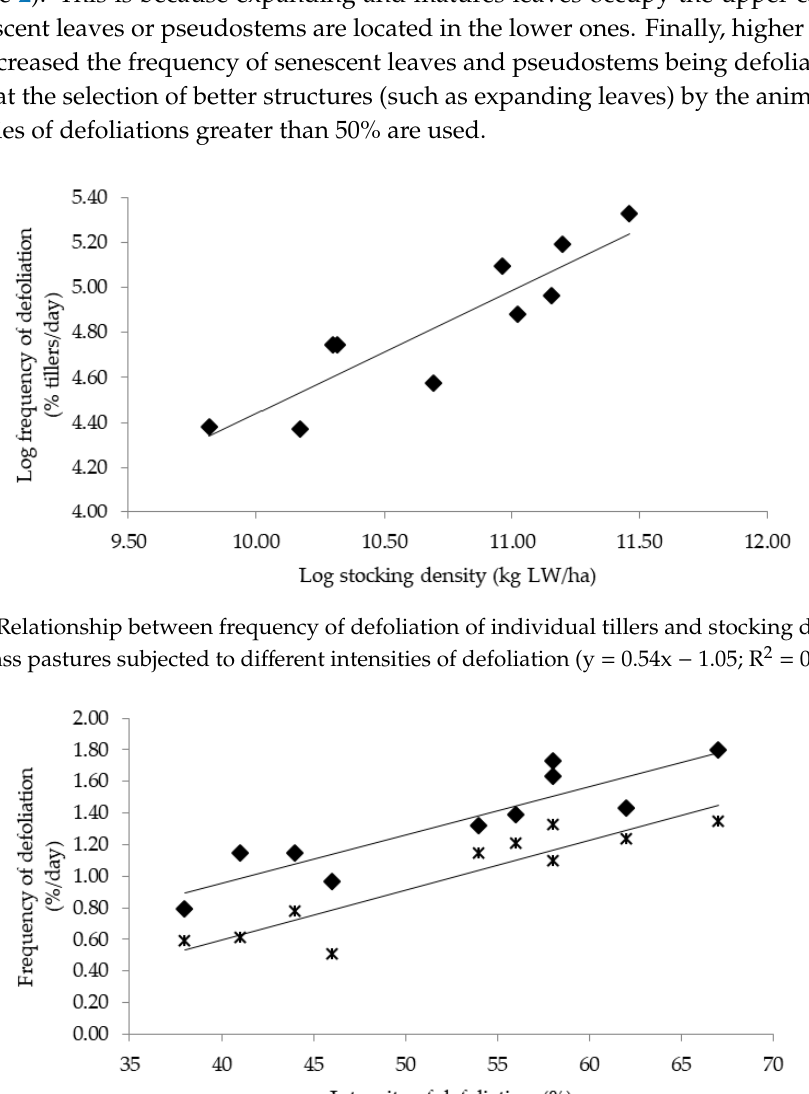
Figure 2. Relationship between the frequency of defoliation and the intensity of defoliation detected from reductions in leaf length ( ♦ ; y = 0.03x − 0.27; R 2 = 0.81) or in extended tiller length ( ж ; y = 0.03x − 0.65; R 2 = 0.84).